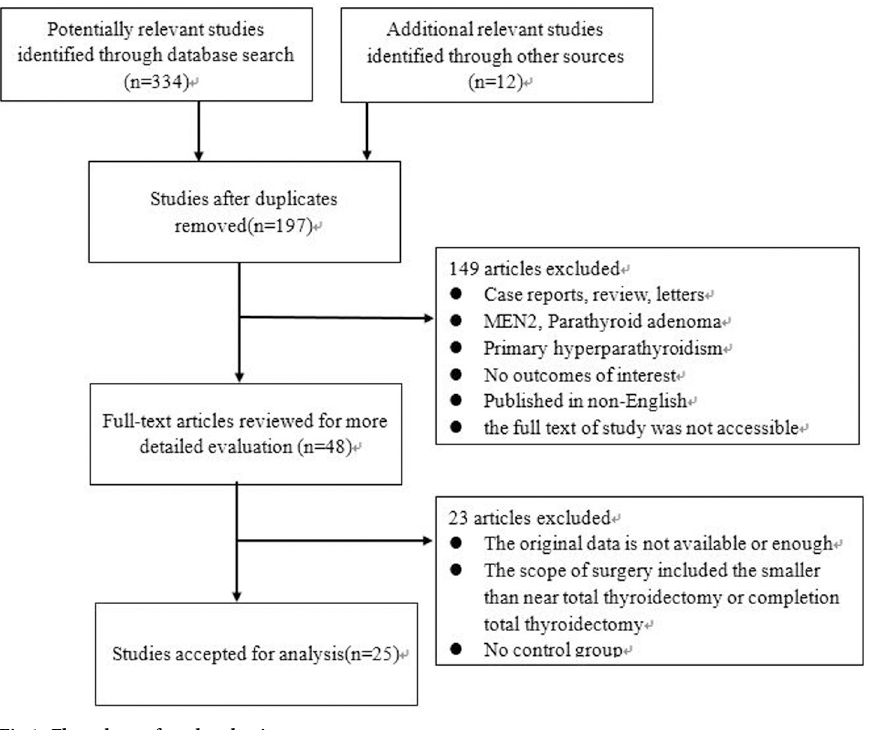
Fig 1. Flow chart of study